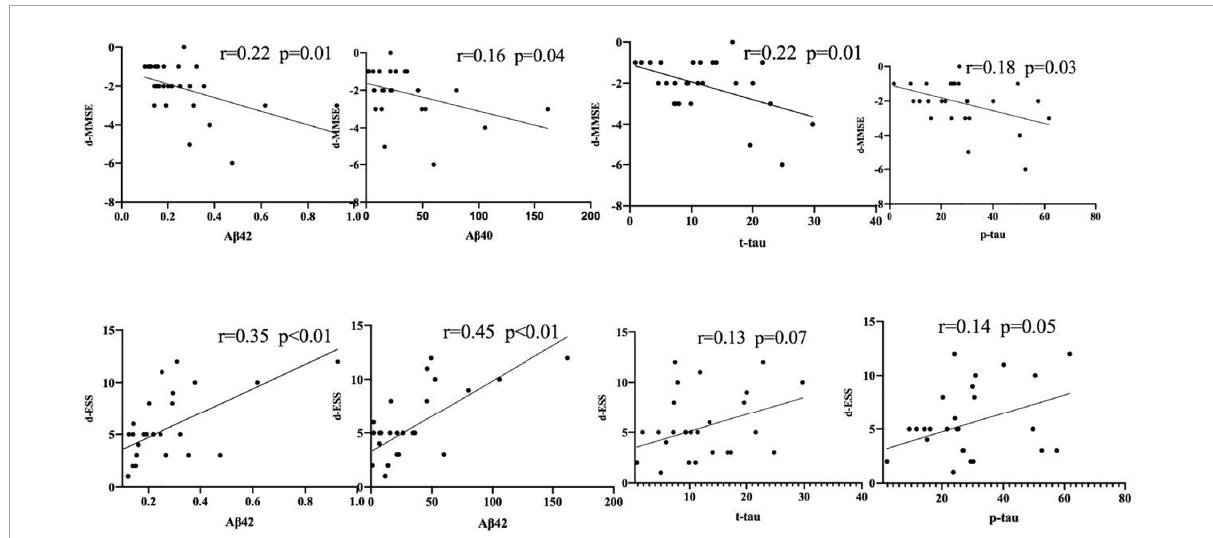
FIGURE4 The significant negative correlations with the plasma levels of A β 42, A β 40, t-tau, and p-tau. The symbol • represents the value of the patient’s